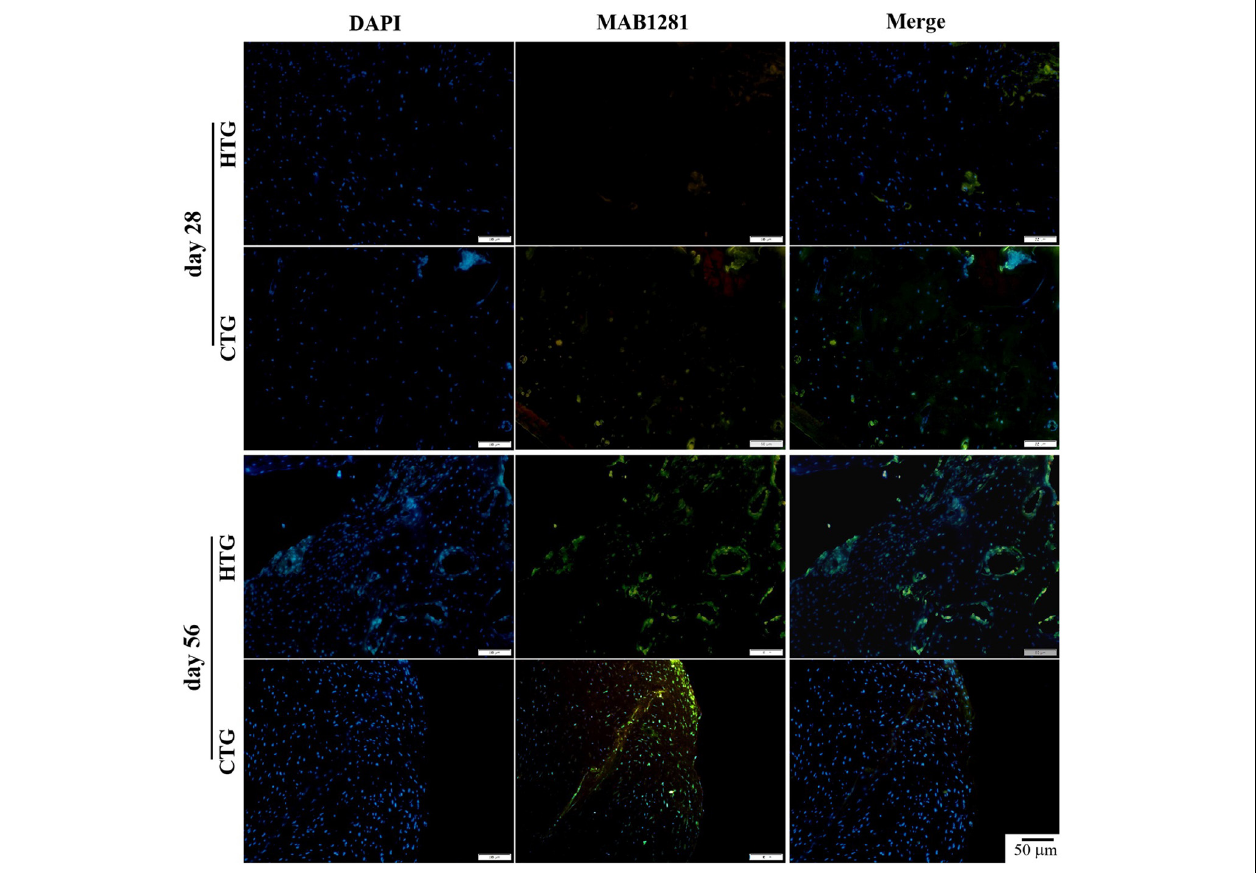
FIGURE 8 | Trace of hAMSCs by MAB1281 antibody in rat OA models. MAB1281 positive cells (green) indicate the human-derived cells. Nucleus: DAPI (blue). NG, LG-DMEM; MG, Model group; HG, 0.05 mg/mL HA; HTG, hAMSCs 1 × 10 6 ; CTG, HA (0.05 mg/mL) + hAMSCs (1 × 10 6 ). Scale bar: 50 µ m. This figure shows the representative immunofluorescence stainings of each group containing three